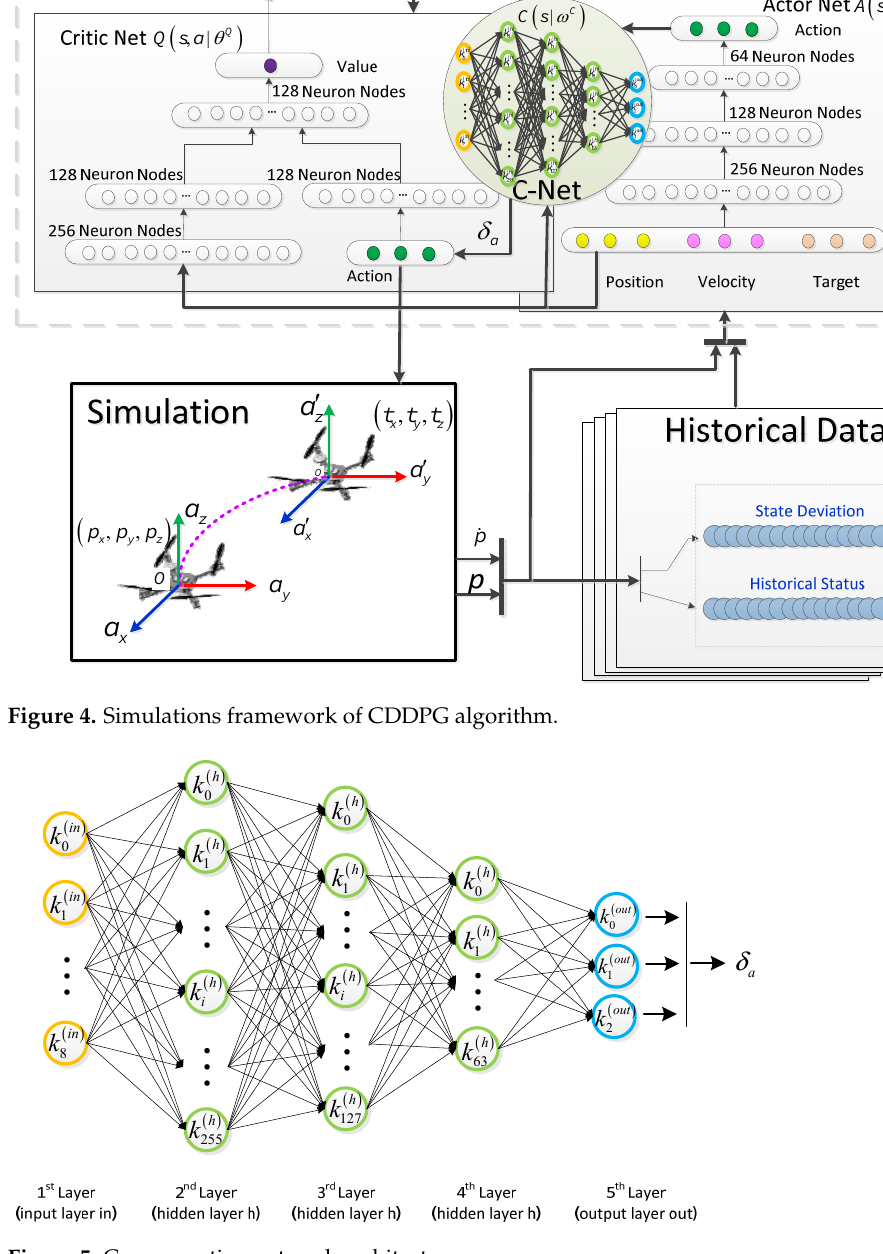
Figure 5. Compensation network